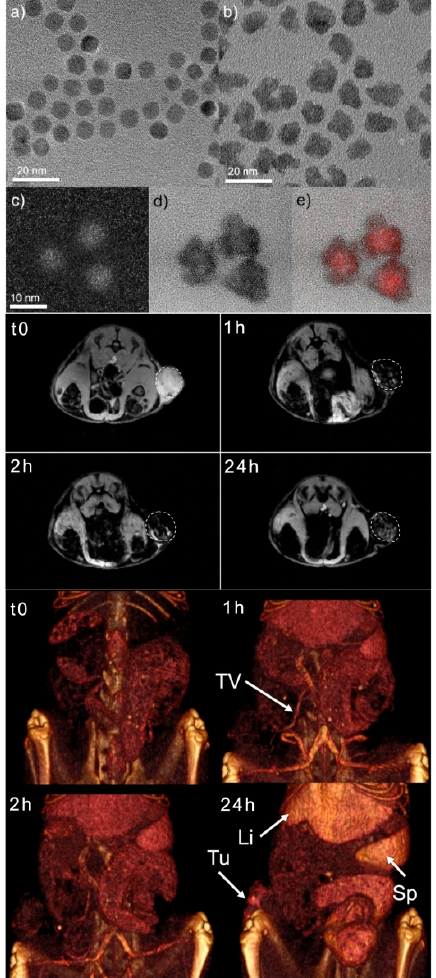
Figure 1. Fe 3 O 4 @TaO x core@shell NPs for dual imaging. ( a , b ) TEM images of magnetite NPs before and after the growth of tantalum oxide shell. ( c – e ) The panel ( e ) shows the overlay of the iron elemental analysis ( c ) and the corresponding bright field image, highlighting the core@shell architecture of the nanostructure. The central panel and the lower one represent the imaging of a rat after administration of the heterostructure, following the intensity of the signal during a time lapse of 24 h. In MRI, the tumor (dashed lines) became darker after a short time from the injection, whereas for CT-imaging the accumulation in different organ was detected during the observation. TV, Li, Tu, and Sp indicate the tumor-associated vessel, liver, tumor, and spleen, respectively. Adapted with permission